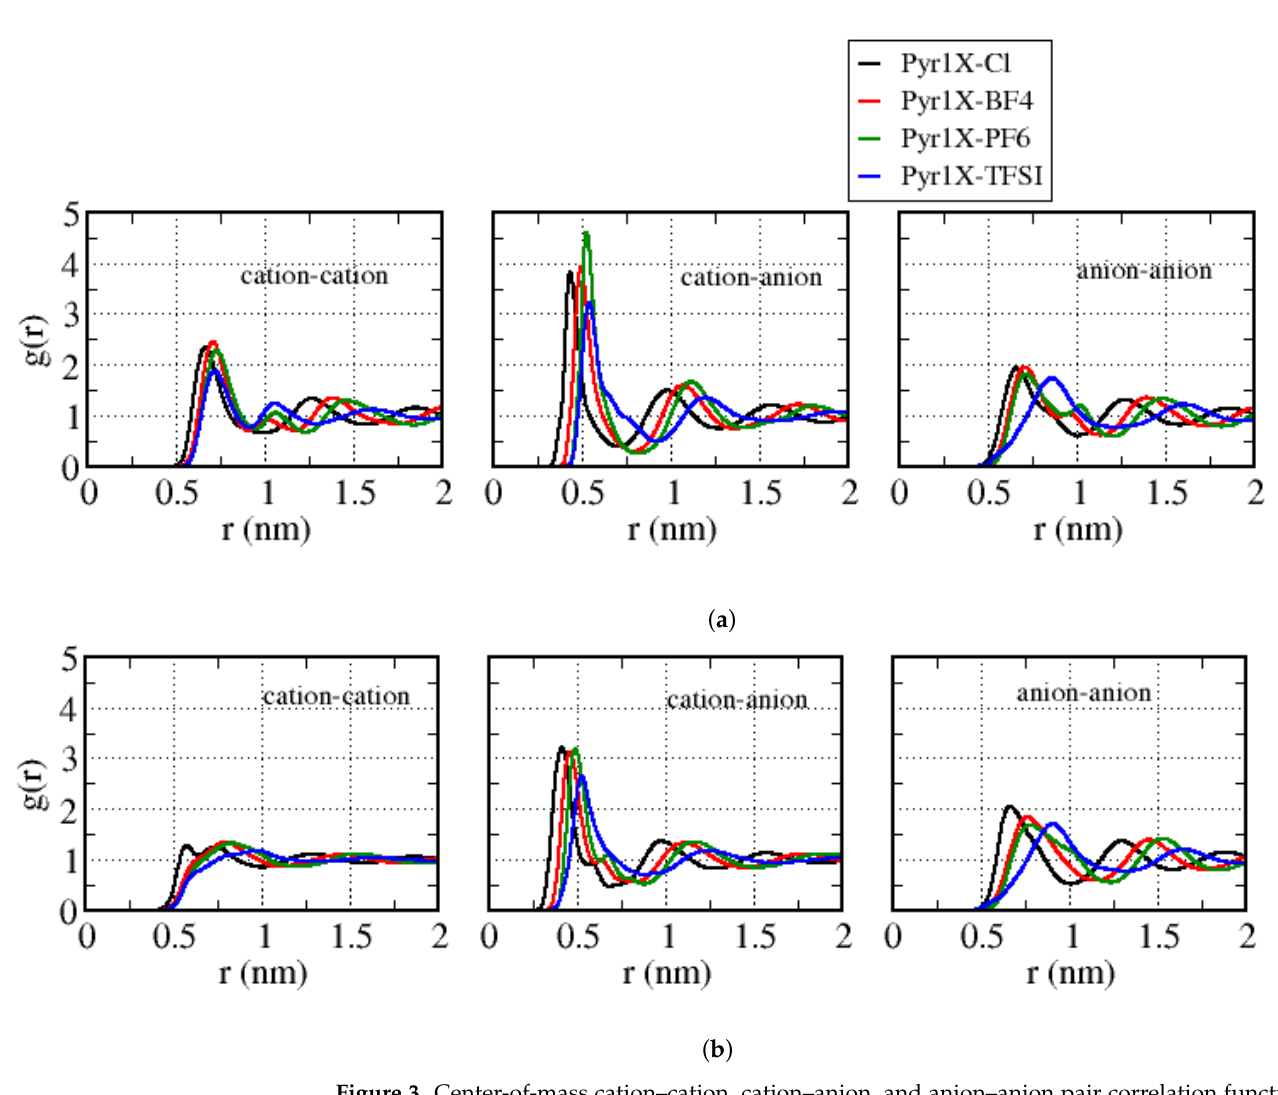
Figure 3. Center-of-mass cation–cation, cation–anion, and anion–anion pair correlation functions ( g ( r )) for all the cation–anion combinations with: ( a ) Pyr12 as the cation; ( b ) Pyr16 as the cation. Table 3. Position of the first peak in cation–anion g ( r ) for all the systems. Values in